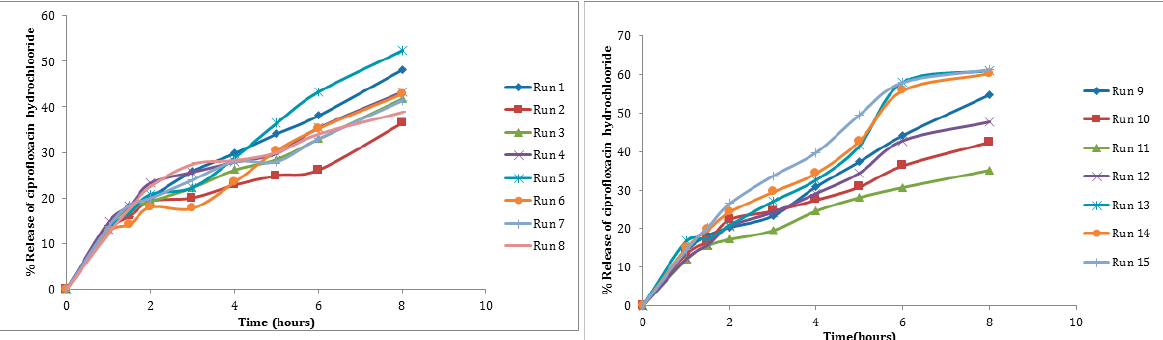
Figure 8. Percent amount released of CHCl from NPs in phosphate buffer (pH 7.4, 37 °C).